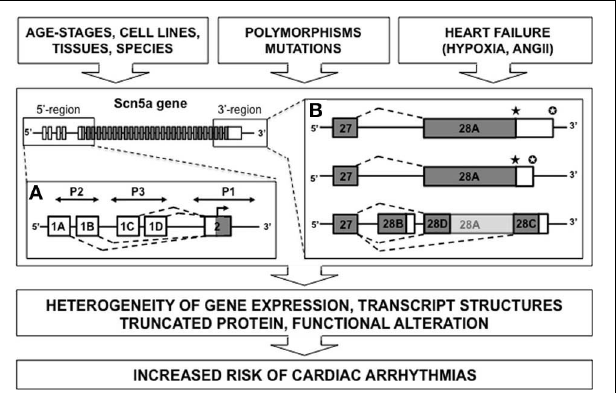
FIGURE 1 | Diagram depicting alternative splicing for SCN5A gene. Multiples mRNA variants were described for the 5 (cid:3) or 3 (cid:3) -untranslated regions (respectively A and B ) (white rectangle, untranslated region; gray rectangle, translated region; P , promoter element; , stop codon; , polyadenylation